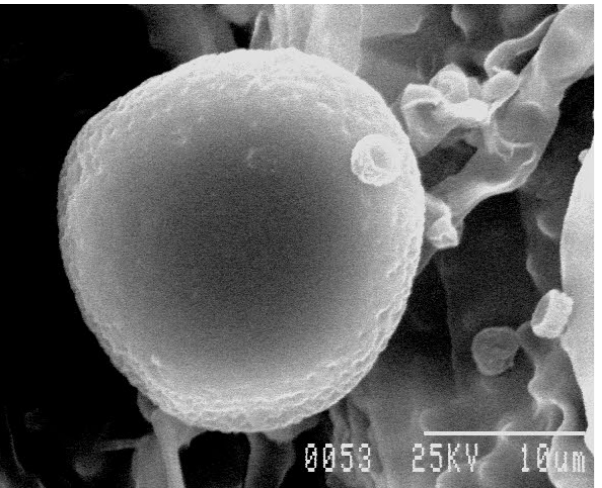
Fig. 13. X3000, exine surface of Nymphaea rubra Roxburgh ex Andrews